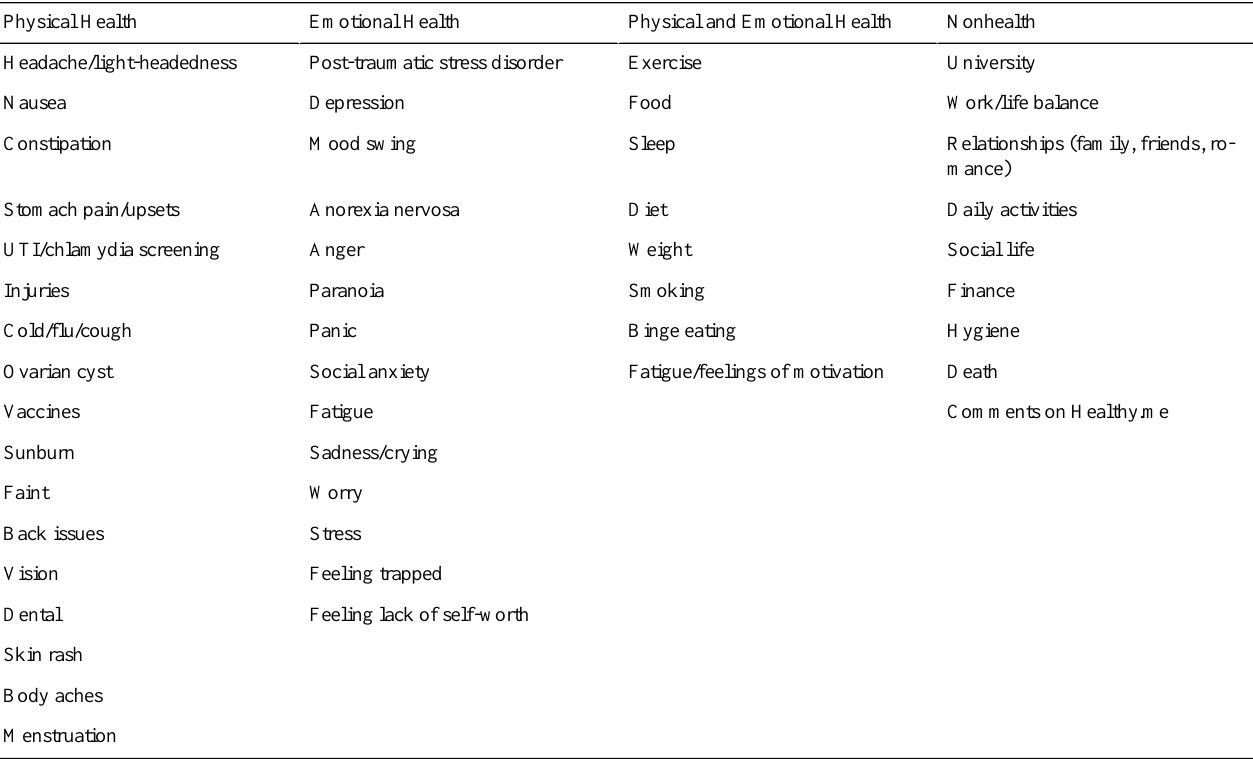
Table 9. Topics recorded by participants in their diary entries (n=140